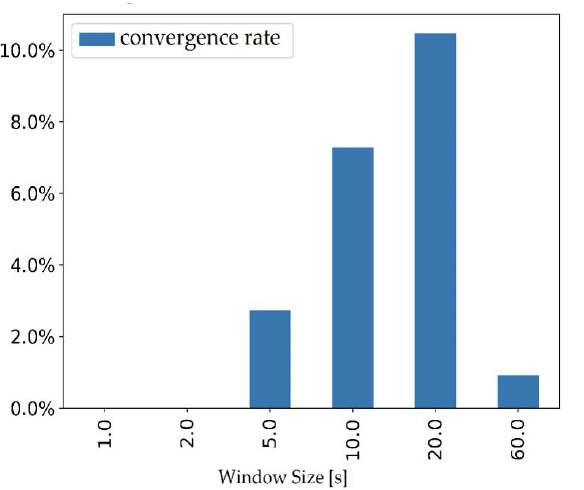
Figure 7. Convergence rate of the AI algorithm versus window size. The convergence rate is the ratio of models that reached a precision of at least 65% on test data and the total amount of models trained for a specific window size.